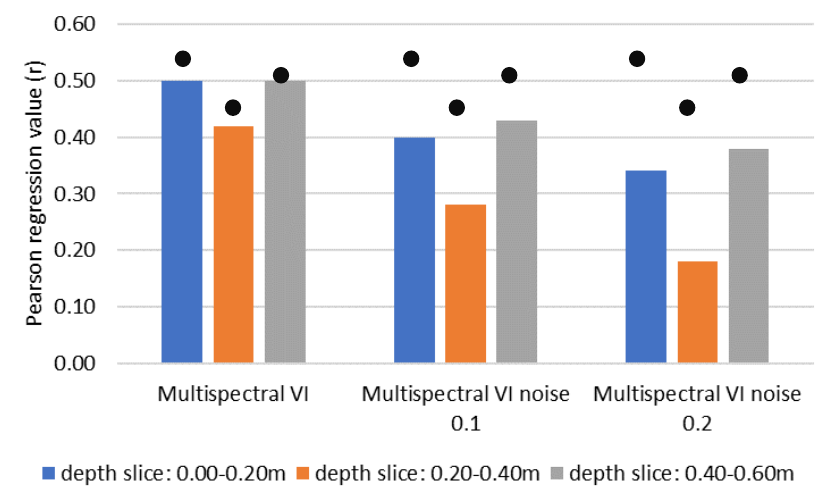
Figure 10. Pearson regression value ( r ) of fusion between the GPR depth slices against the 13 multispectral vegetation indices (with and without noise) (see details for multispectral indices in Table A1, Appendix A). Correlation achieved with the noiseless dataset is shown with a dot for each depth slice.